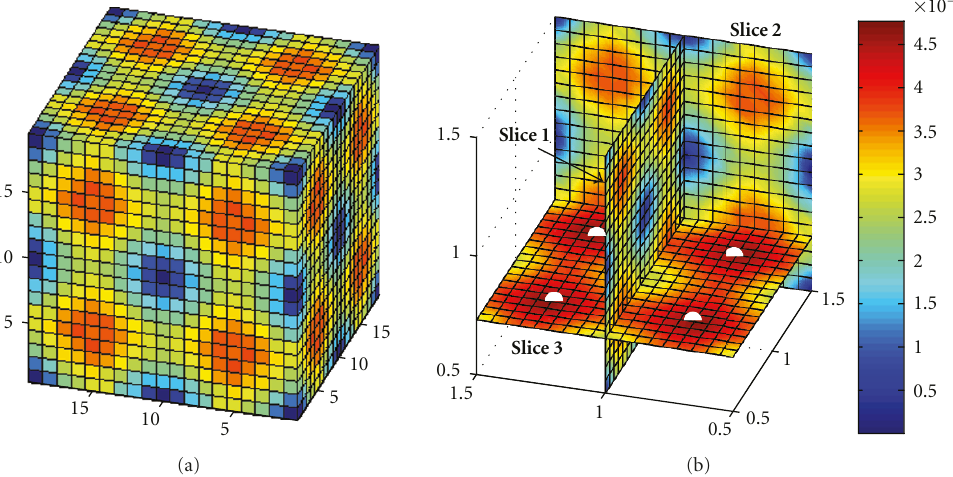
Figure 7: (a) The OCV showing the error of the marker tracking method, each grid locations tested. (b) Three 2D image slices through the OCV for the best (Slice 1 and 2) and worst locations (Slice 3).